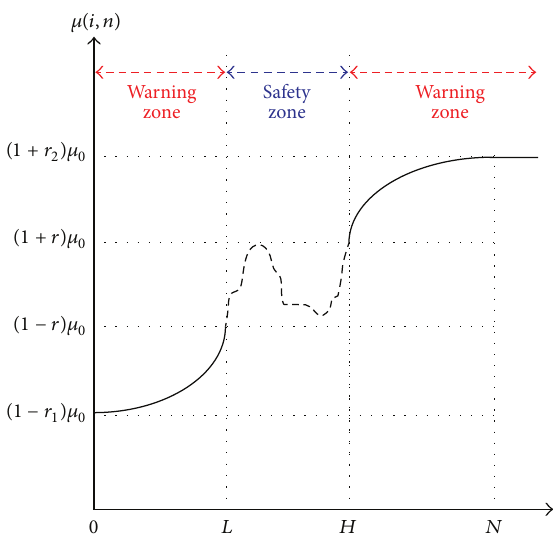
Figure 2: The playout rate function of DPTA+APTA playout system